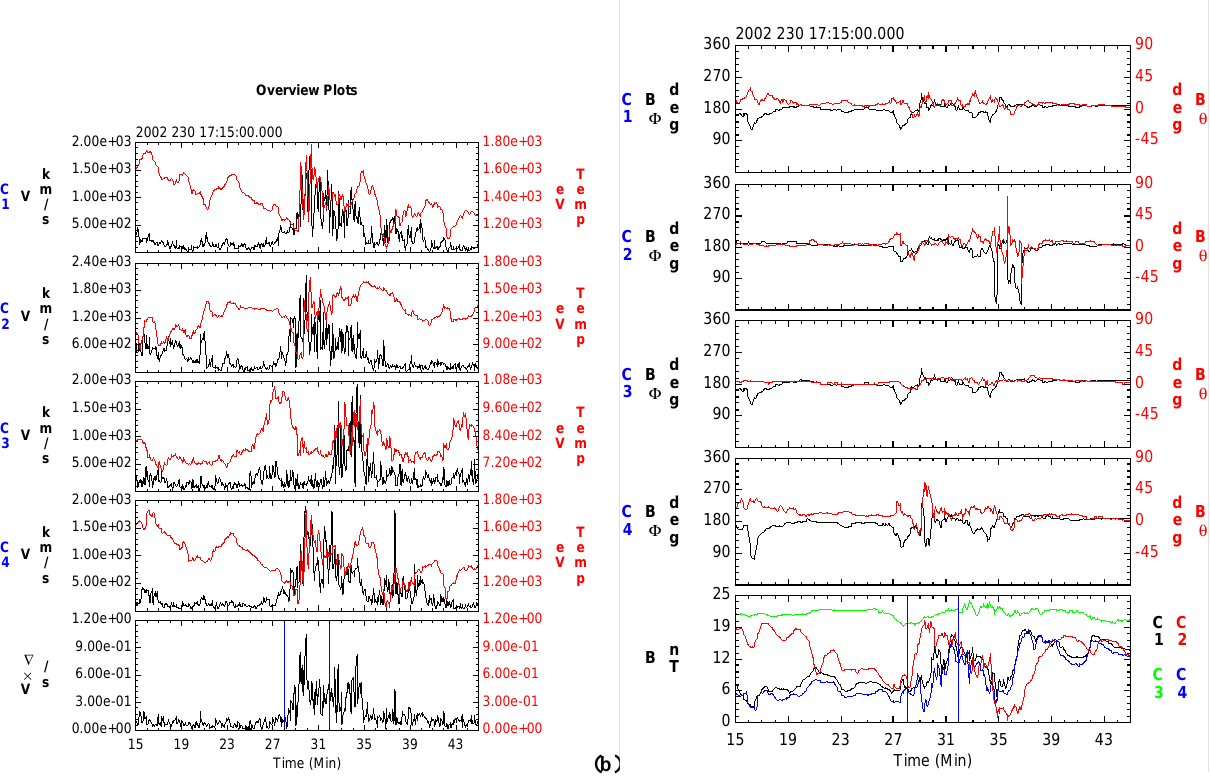
Fig. 6. Comparison of the total electron velocity and temperature and the magnetic field signatures from all four spacecraft across the vorticity burst associated with the second ion diffusion region seen in Fig. 1.